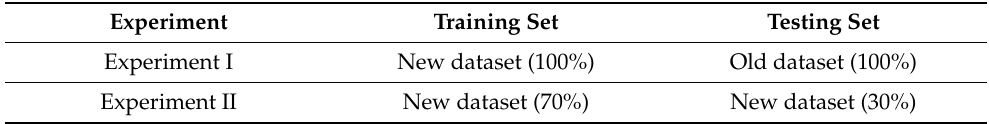
Table 8. Datasets’ Distribution for Experiments of Part